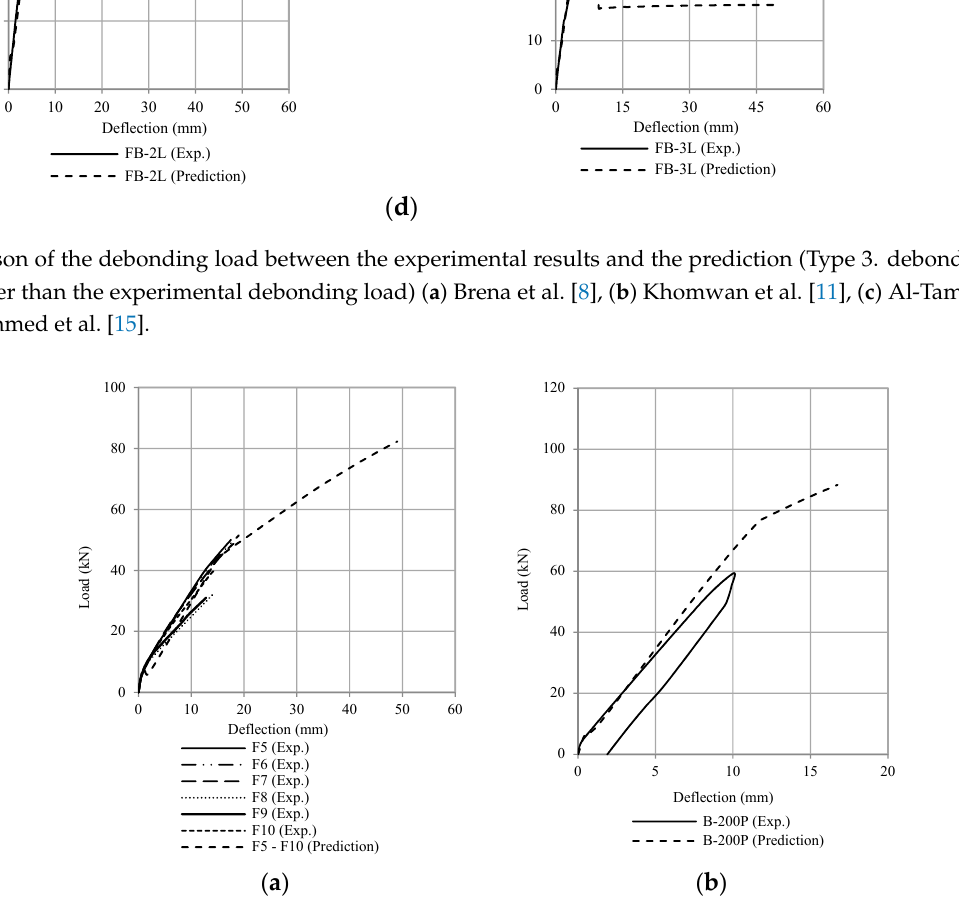
Figure 22. Comparison of the debonding load between the experimental results and the prediction (Type 4. the value of the calculated debonding moment is higher than the ultimate nominal moment of the cross-section) ( a ) Fanning and Kelly [7], and ( b ) Pimanmas et al. [10].